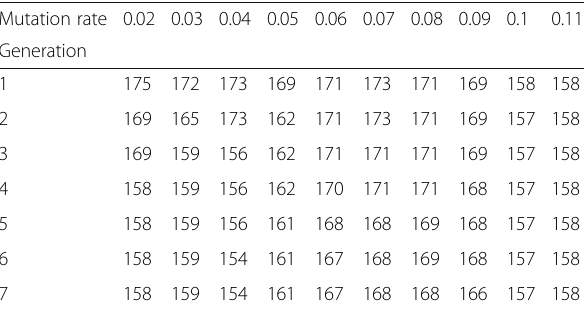
Table 16 The impact of the mutation rate on the genetic algorithm accuracy